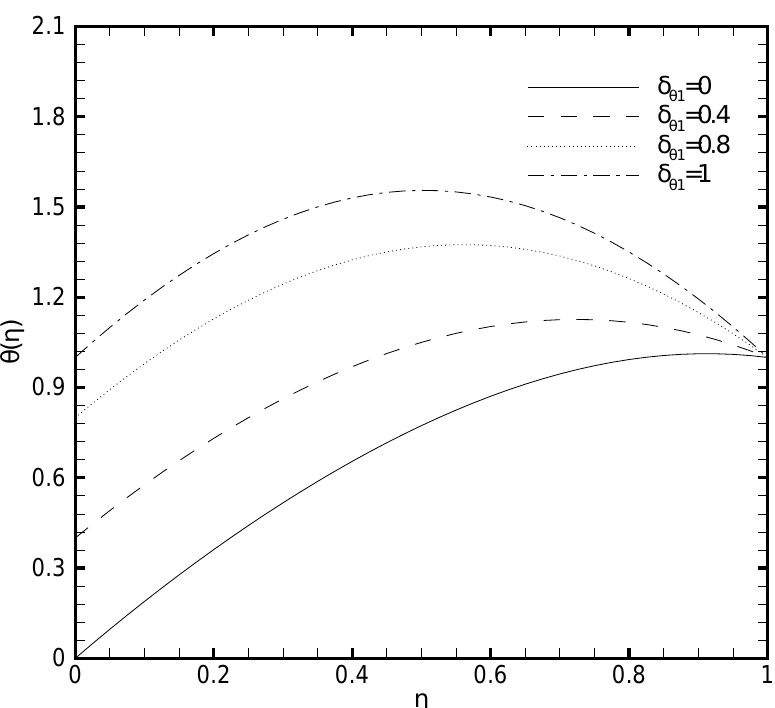
Figure 9. Temperature profile θ ( η ) for several values of a constant δ θ 1 when ζ = P = κ = Ha = Br =